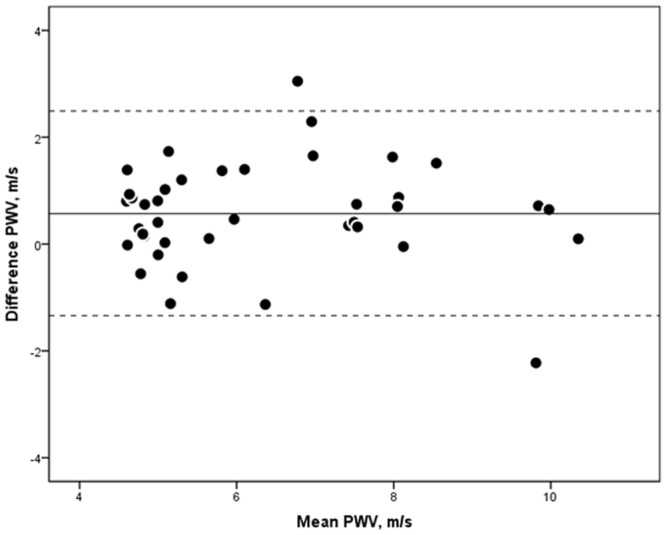
Methods´ agreement.Bland-Altman plots representing the agreement between the oscillometric method and cardiac magnetic resonance for the assessment of aortic pulse wave velocity. Corresponding coefficient of variation was 15%.